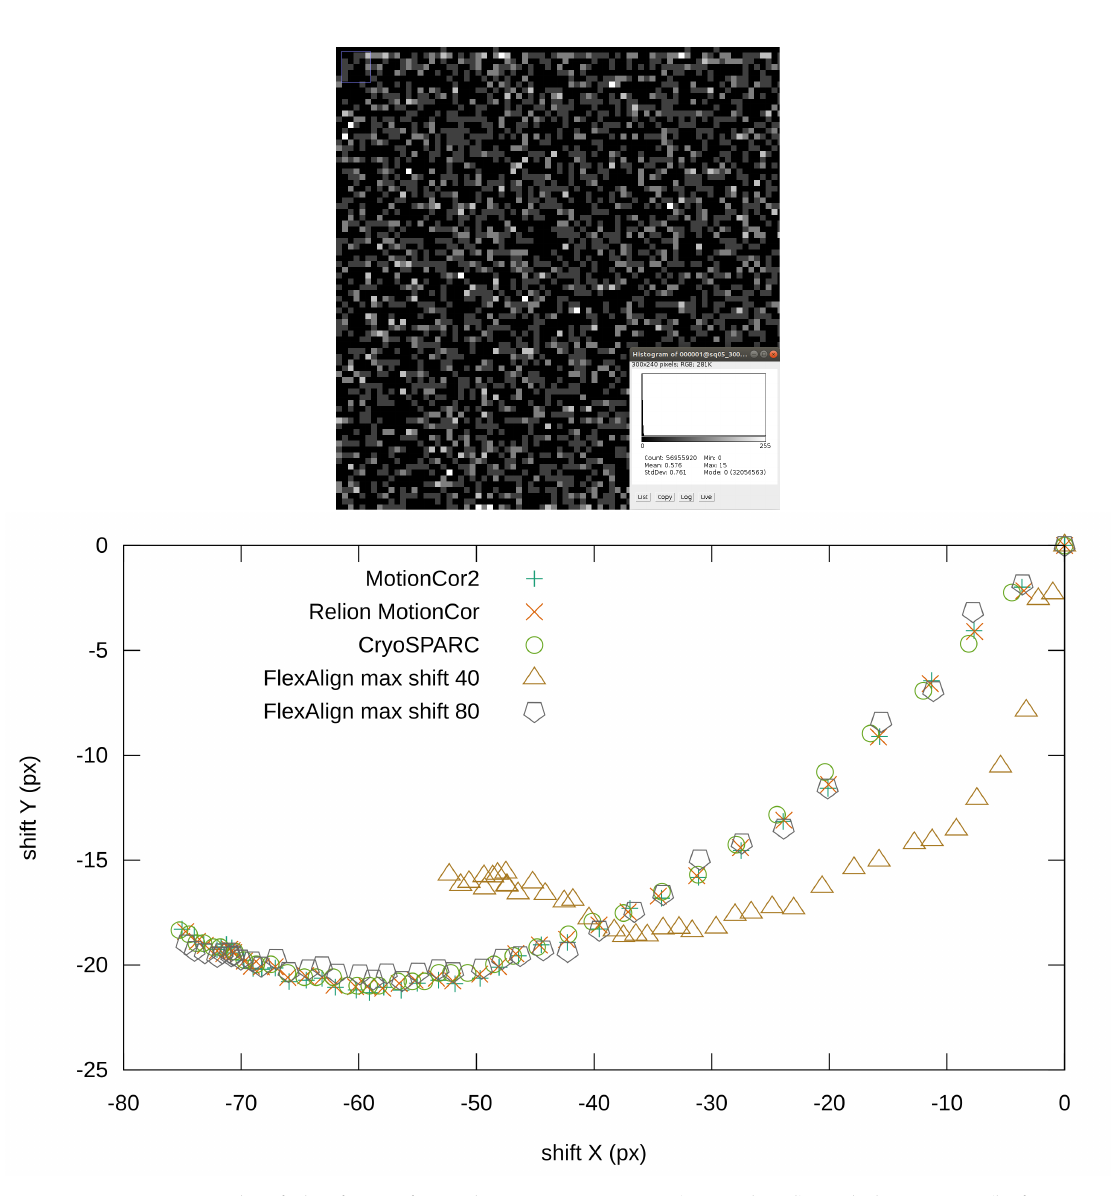
Figure 14. Details of the frame from the EMPIAR 10196 (normalized) with histogram (before normalization) ( top ), reported global shifts by different programs ( bottom